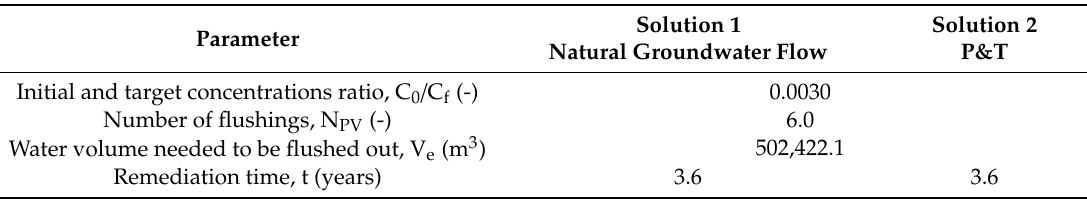
Table 5. ADR model results for the field